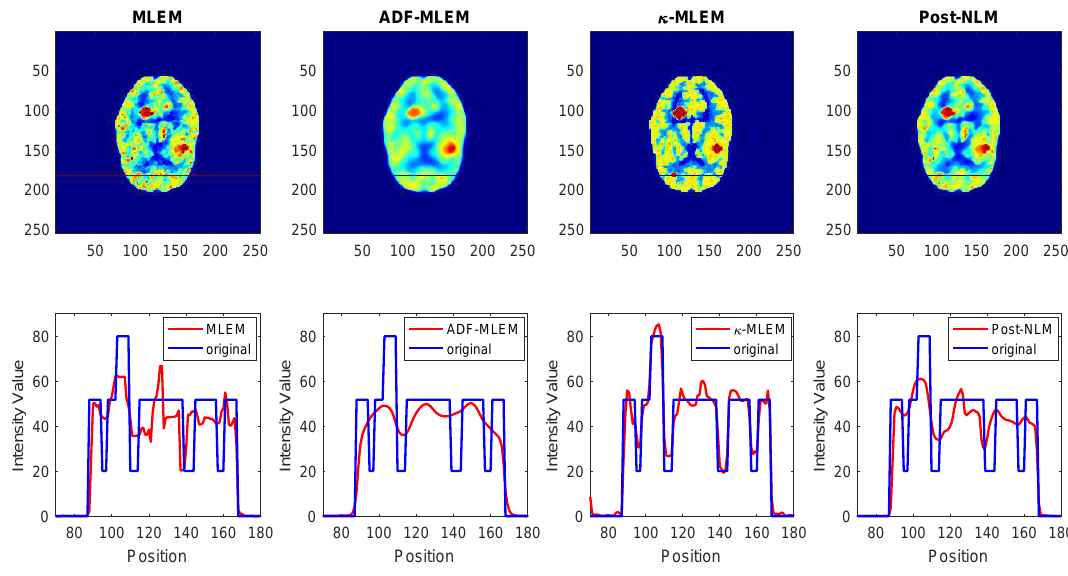
Figure 8. 1D profiles corresponding to reconstructed images for the small tumor.